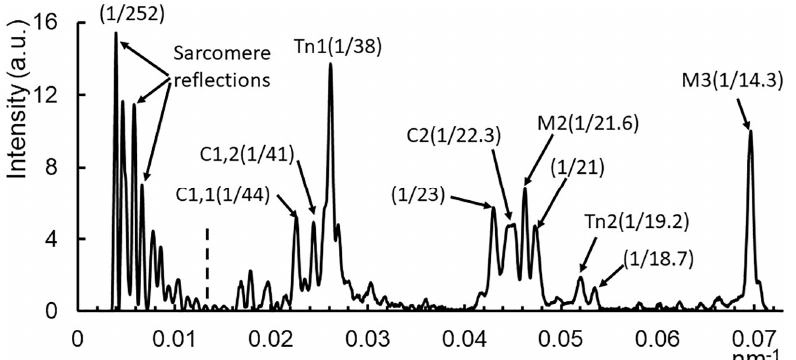
Figure 2. Low order meridional reflections in resting muscle. The meridional reflections, including high order sarcomere repeat, M1 cluster, M2 cluster, and M3 reflection. Taken from resting muscle with a 9 m sample to detector distance. Integration region is from 0.03 nm − 1 to 0.077 nm − 1 in reciprocal space (white box in Figure 1B). Reflection intensities to the left of the dotted line are scaled down by a factor of 15 for visibility. C1: lowest angle myosin binding protein C reflection; C2: second myosin binding protein C reflection (doublet with C1); M2: second order myosin meridional X ‐ ray reflection; M3: third order myosin meridional X ‐ ray reflection; Tn1: 1st order troponin reflection; Tn2: 2nd order troponin reflection. To examine the layer lines more closely, a radially integrated intensity trace (from 0.03 nm − 1 to Int. J. Mol. Sci. 2018 , 19 , x FOR PEER REVIEW